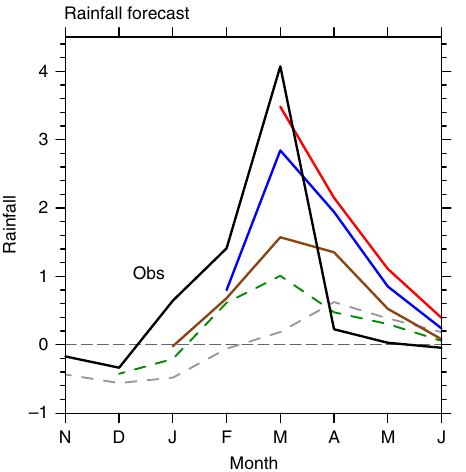
Fig. 9 Predictions of the 2017 extreme coastal rainfall from the NMME. Rainfall (mm day − 1 ) forecasts over CTSA initialized on 1 November 2016 (gray dashed), 1 December 2016 (green dashed), 1 January 2017 (brown), Fig. 10 Schematic for the 2017 extreme coastal El Niño. FMA wind (m s − 1 ; blue arrows) and temperature anomalies (°C; color shading) along the American coast, with the 20 °C isotherm for climatology and 2017 highlighted in gray and red lines, respectively. The meridional atmospheric circulation anomalies are indicated by the pink arrows. The ellipse indicates WES feedback and oceanic downwelling favorable process. The cumulonimbus south of the equator denotes deep